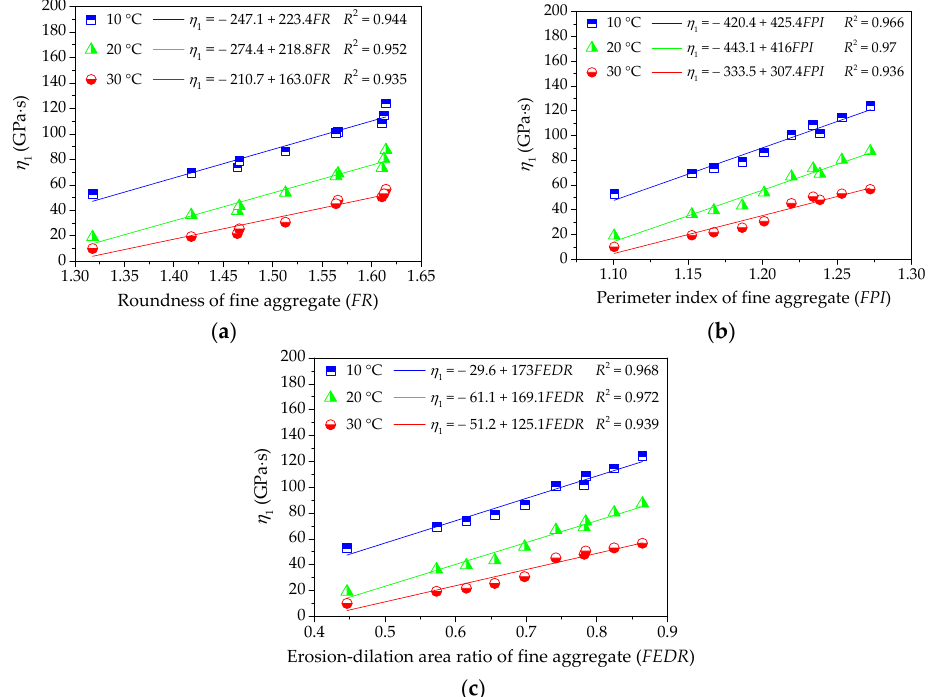
Figure 7. Influences of fine aggregate morphological characteristics of on η 1 of asphalt mortar: ( a ) Shape ( FR ); ( b ) Angularity ( FPI ); and, ( c ) Texture ( FEDR ).